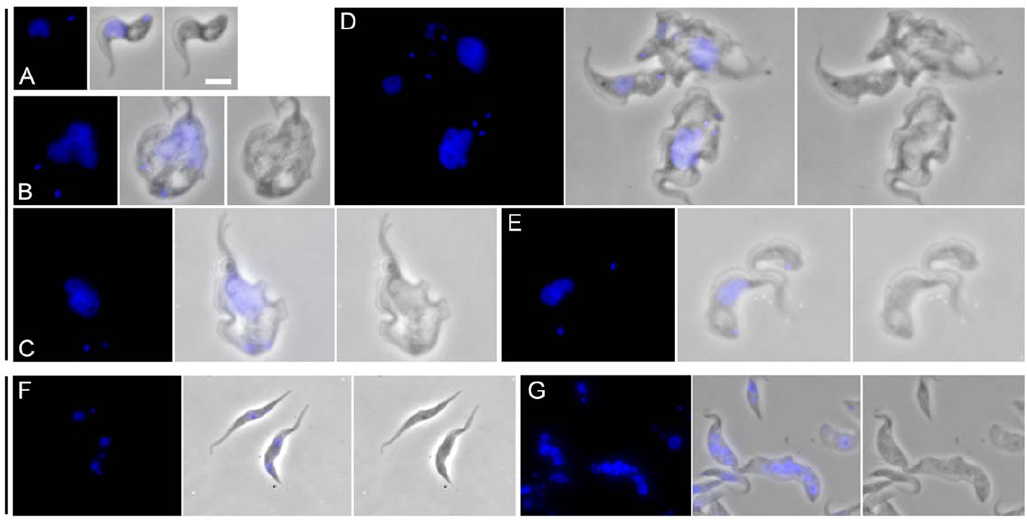
Figure 4. Gallery of morphotypes associated with RNAi of TbRHP in trypanosomes. (A and B) Uninduced BSF cells harboring the p2T7 N TbRHP RNAi construct. (C–E) BSF cells induced for 24 hours, selected to illustrate the range of abnormal morphotypes, including multi-nucleate/ multi-flagellar morphologies. The continued juxtaposition of apparently post-mitotic nuclei in these cells is evident in (C) and (D), suggesting a defect in migration following the completion of nuclear division. (F) Uninduced PCF cells harboring the p2T7 N TbRHP RNAi construct. (G) PCF cells induced for 48 hours, selected to illustrate the fully segregated multinuclear phenotype. Each panel shows DAPI (blue) at left, phase contrast at right and channel merge at centre. Bar in (A), 3 m m. doi:10.1371/journal.pone.0026890.g004 phenocopies TbRHP RNAi, consistent with acting in the same pocket (Figure 8E). This is also similar to the localization of H. pathways. We localized in situ tagged TbOCRL to a cytoplasmic location but excluded from the nucleus and similar to TbRHP (Figure 8E). Interestingly TbOCRL also localized to one or two puncta at the tip of the cell or near but not at the flagellar pocket